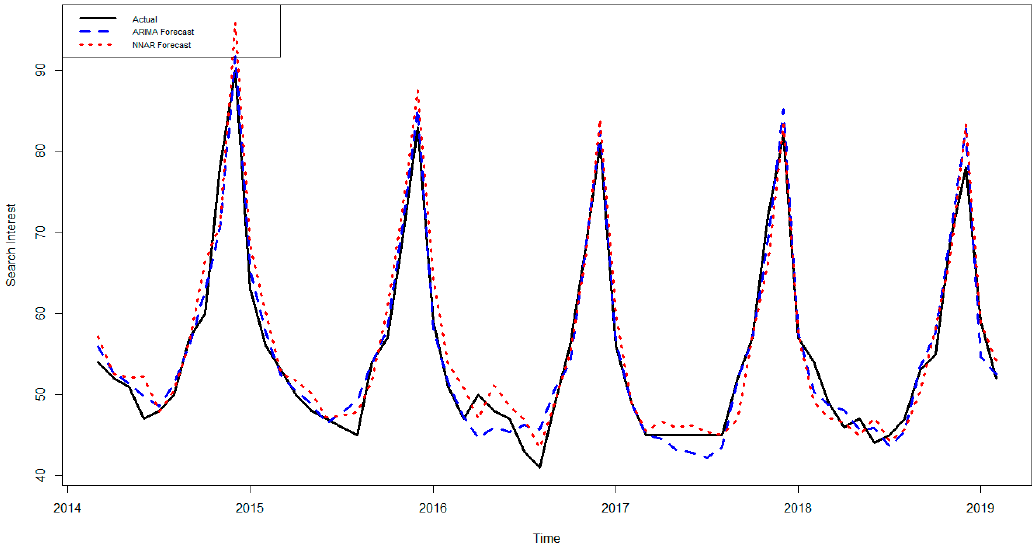
Figure 10. Out-of-sample forecasts for “Burberry” fashion consumer Google Trends at h = 1 month-ahead from ARIMA and NNAR